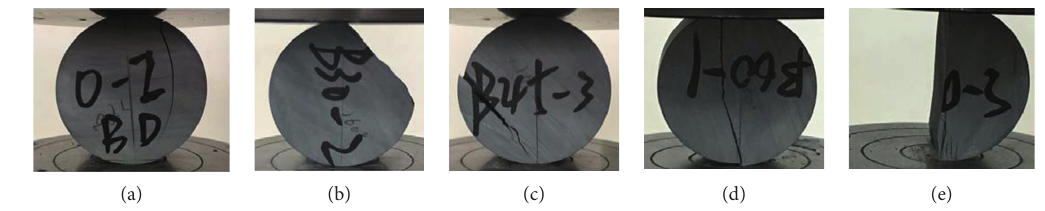
Figure 4: Failure mode of slate in the Brazilian test.